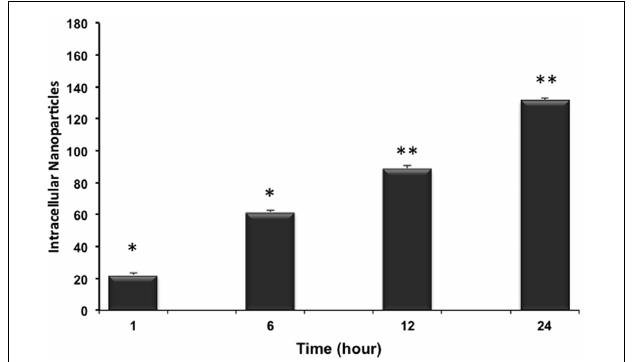
FIGURE 5 | Uptake kinetics of RhB-loaded PLGA NPs. Within the 24 h the mean number of internalized NPs in cardiomyocytes increases significantly and almost linearly. Results are statistically different ( ∗ p < 0.05; ∗∗ p < 0.01) for time points 1–24 h. Results are expressed as mean ± standard deviation, n =